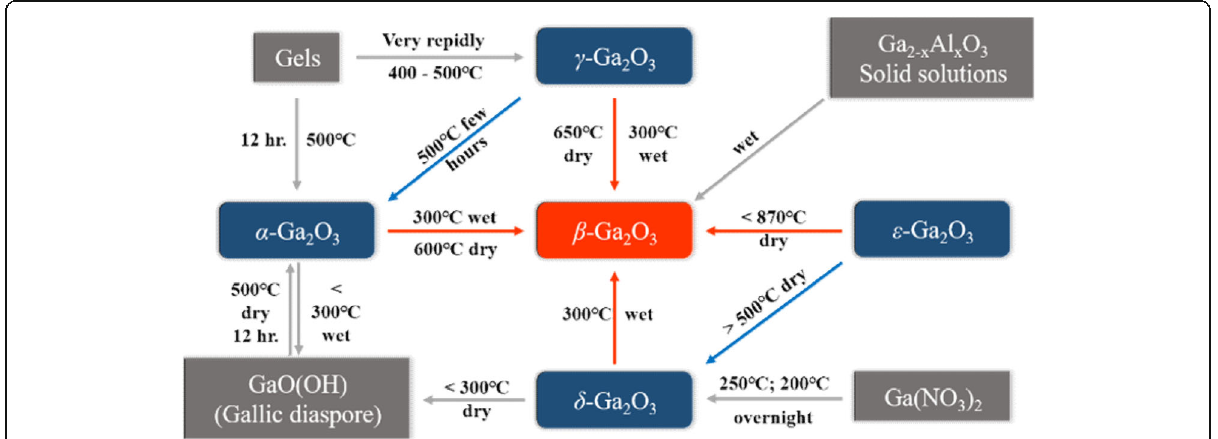
Fig. 1 Transformation relationships among the crystalline phases of Ga2O3 and their hydrates